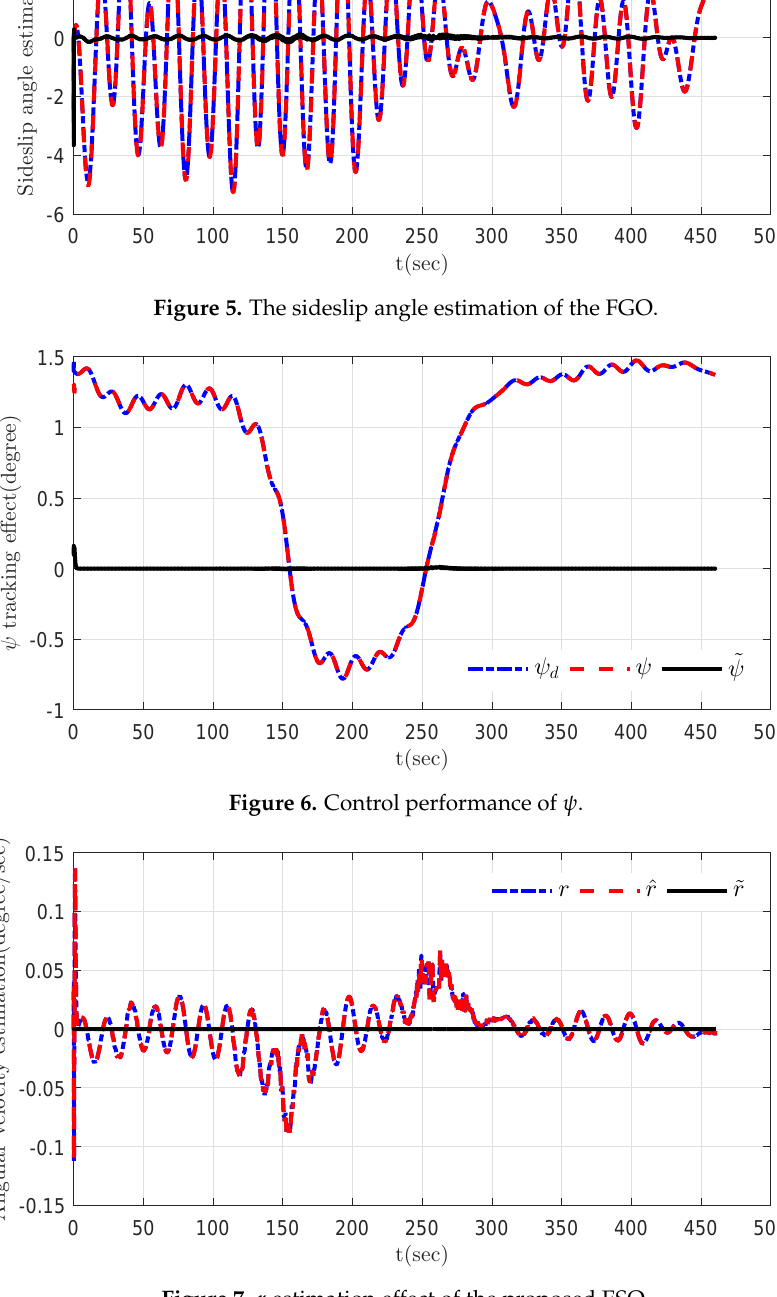
Figure 7. r estimation effect of the proposed